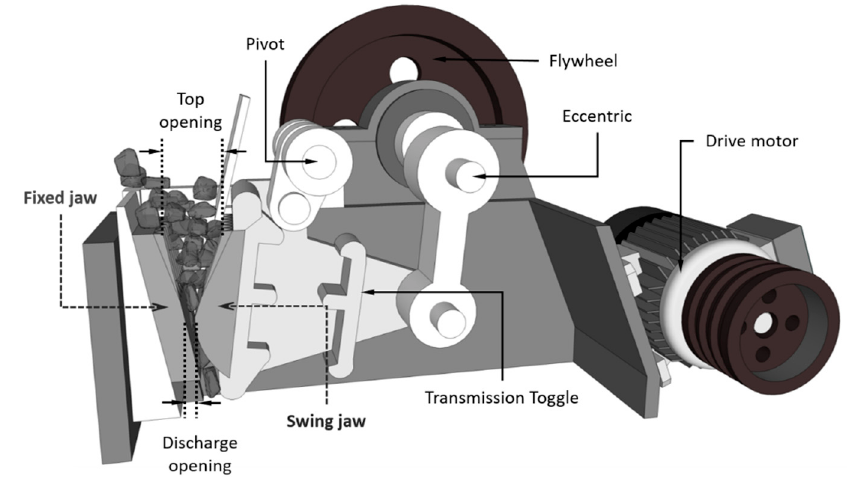
Figure 3. Scheme of the jaw crusher showing the main components of the machine.